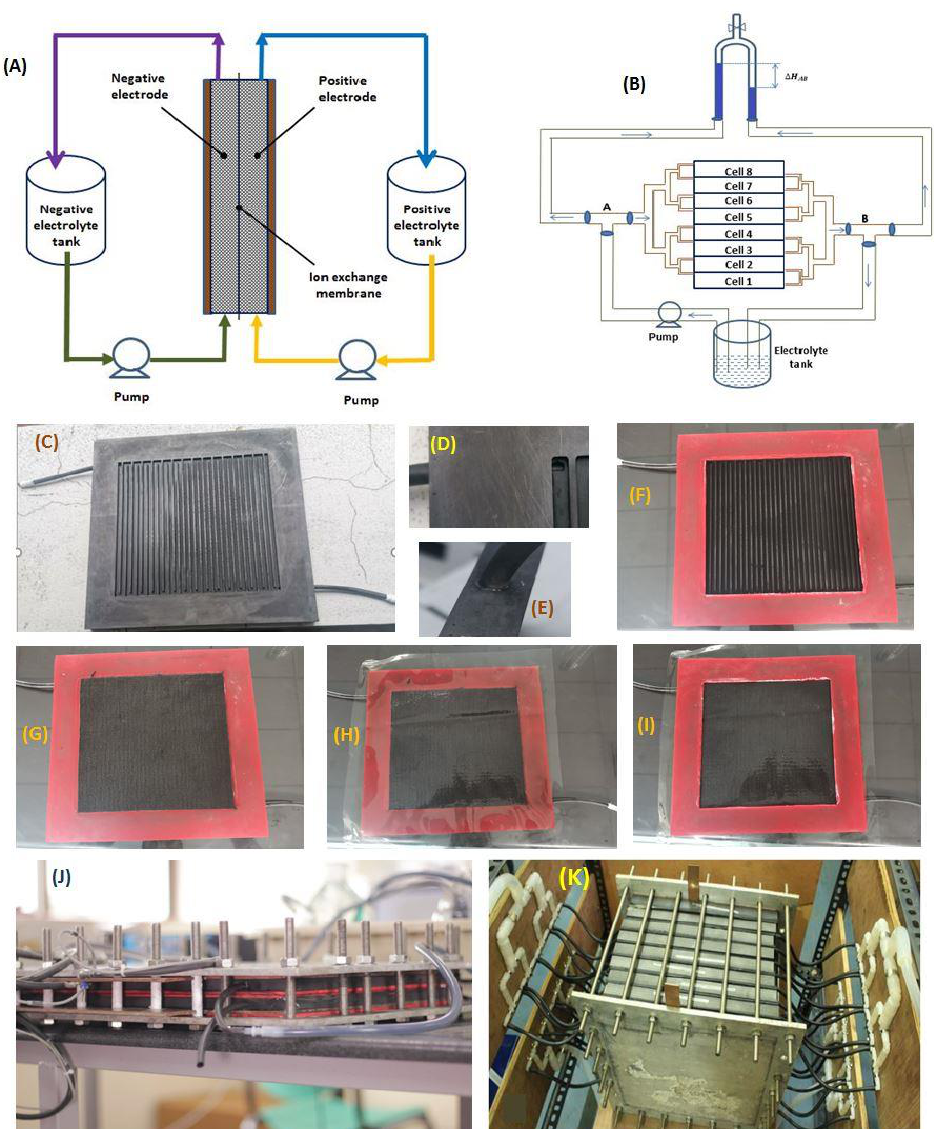
Figure 1. Details of the stack construction: ( A ) schematic of a redox flow battery, ( B ) manometer arrangement for in situ pressure-drop measurement in the stack, ( C ) graphite plate with serpentine flow field and inlet/outlet feed tubes, ( D , E ) details of arrangement of flow feed through a Viton tube inserted into the side of the graphite plate, ( F ) overlaying of silicone gasketoverlaid on thegraphite overheads, ( G ) filling of flow channel with carbon felt, ( H ) placing membrane over the plate and the electrode, ( I ) placing of another silicone gasket over the membrane to house the adjacent electrode felt, ( J ) assembled single cell and ( K ) integrated 8-cell stack with split manifold.